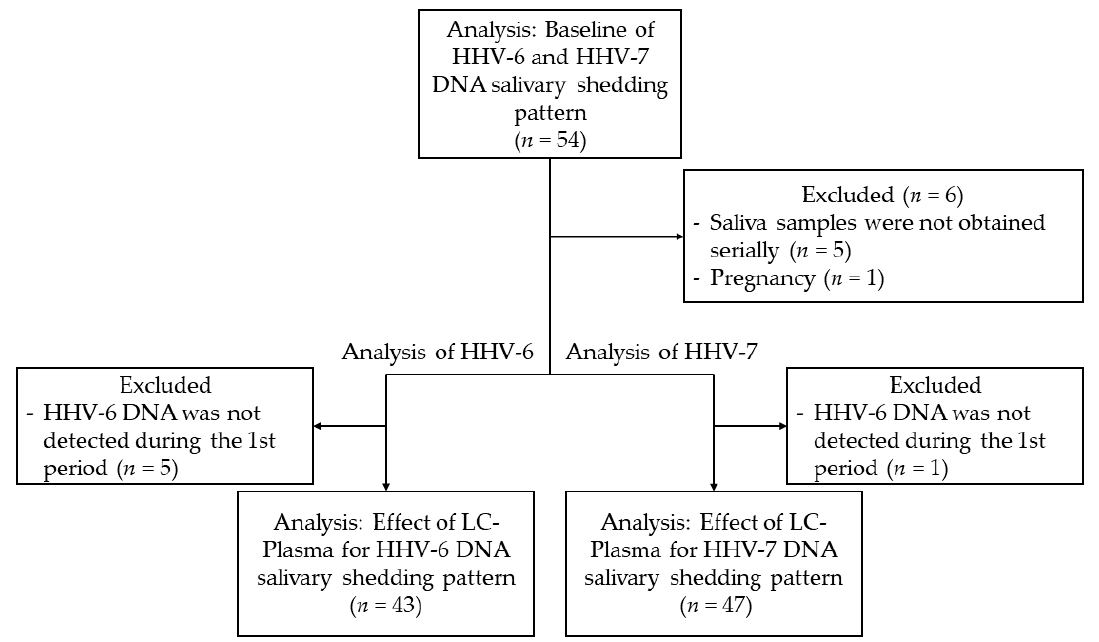
Figure 2. Flowchart of the selection process: Initially, 54 volunteers were enrolled in this study, and all subjects were analyzed for baseline HHV-6 and HHV-7 DNA salivary shedding patterns. Subjects who did not meet the inclusion criteria were excluded from the analysis of the effects of LC-Plasma on HHV-6 and HHV-7 DNA salivary shedding patterns.